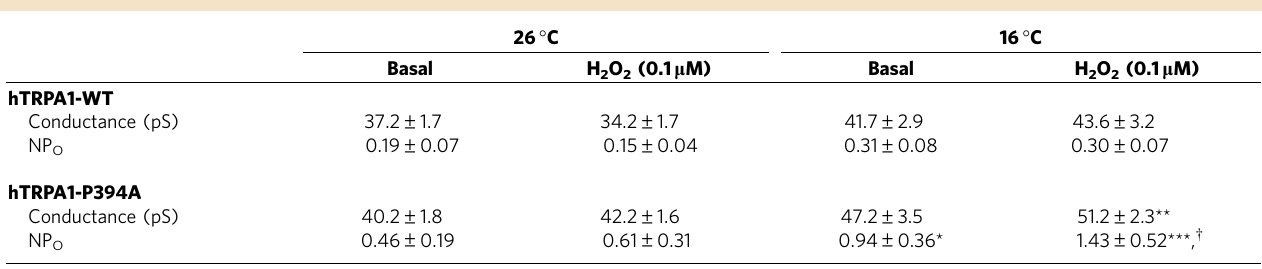
hTRPA1-P394A Conductance (pS) Single-channel conductance and open probability (NP O ) of single-channel currents were measured in hTRPA1-WT- or hTRPA1-P394A-expressingcells at 26 or 16 (cid:2) C in the presence or absence of H 2 O 2 (0.1 m M) using inside-out patches at a membrane potential of (cid:2) 60mV as shown in Fig. 1e–g. n ¼ 13–14. * P o 0.05. ** P o 0.01. *** P o 0.001 versus data from the same channel at 26 (cid:2) C in the absence of H 2 O 2 ; w P o 0.01 versus hTRPA1-WTunder the same condition; two-way repeated measures ANOVA with Bonferroni’s post hoc test. All data are expressed as mean ± s.e.m.